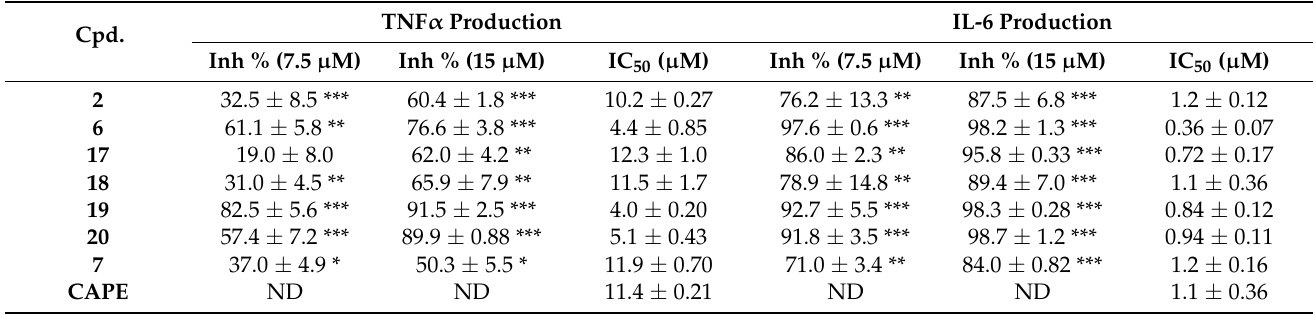
Table 4. Effects of NF- κ B inhibitors on TNF α and IL-6 production in LPS-activated dTHP − 1 cells.